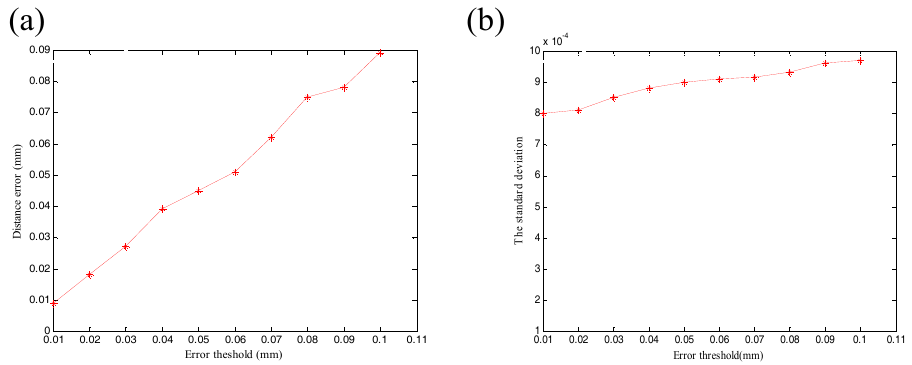
Figure 15. Error analysis of accurate registration results, ( a ) the average distance error variation, ( b ) the standard deviation variation. Table 2. Matching simulation results of knee bone model and Chinese lion model.